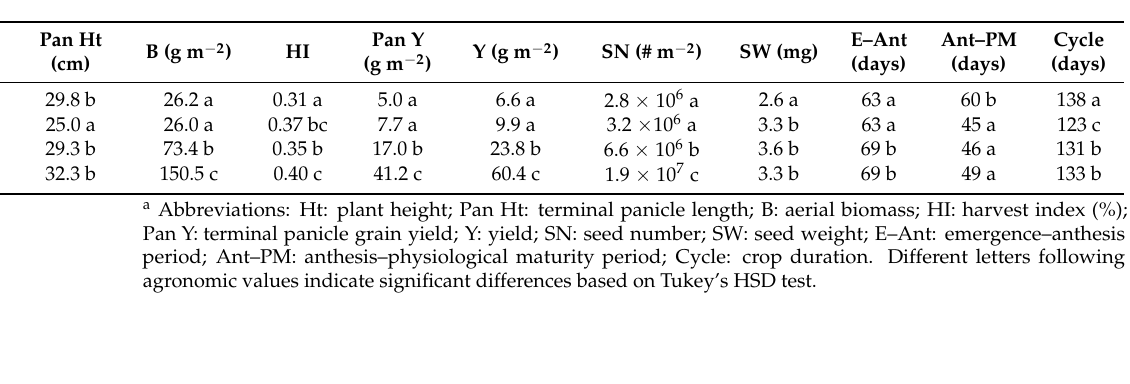
Figure 1. Dendrogram showing 117 genotypes of quinoa grouped according to Ward cluster analysis using 11 phenotypic traits. To the left of the dendrogram the groups are named according to the ecotype classification based on microsatellite markers by [22]. To the right of the dendrogram the groups are named according to the classification obtained in the present study; G1: genotypes from Peruvian and Bolivian highlands, G2: genotypes from Bolivian highlands, G3: genotypes from Ball ó n collection and Bolivian highlands and G4: genotypes from Ball ó n collection and Sea Level. See Table S1 for more information about genotypes codes and both classifications. Table 3. Agronomic traits of the four genotype groups resulting from a hierarchical agglomerative clustering